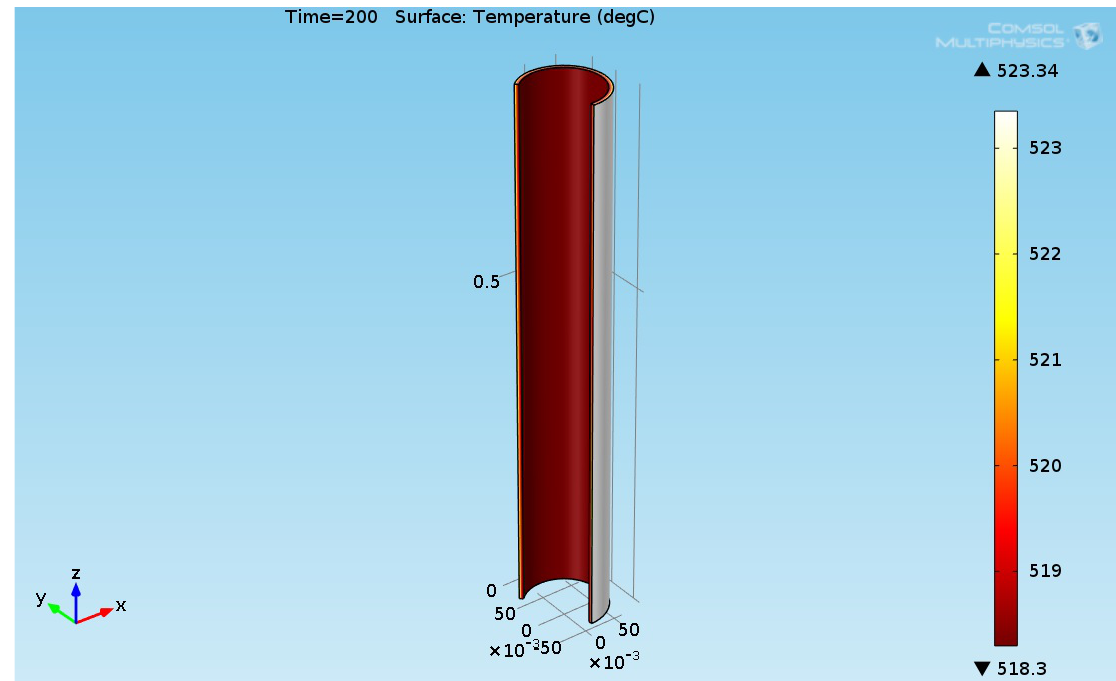
Figure 24. 3D plot of the reboiler tube temperature field.